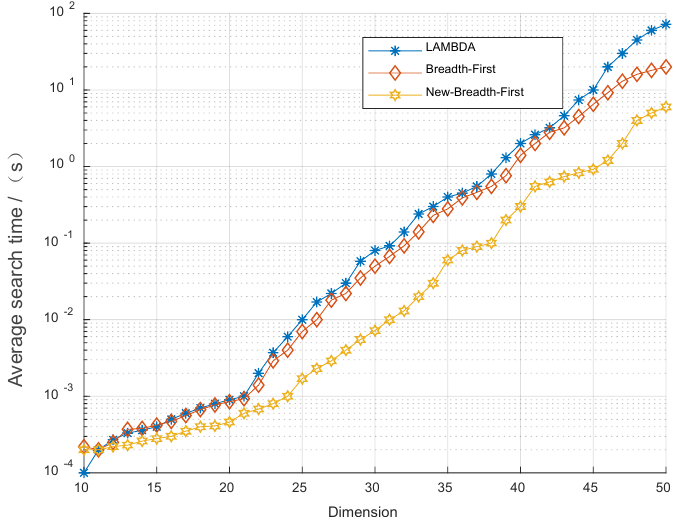
Figure 5. Simulation diagram of ambiguity search time of three algorithms.